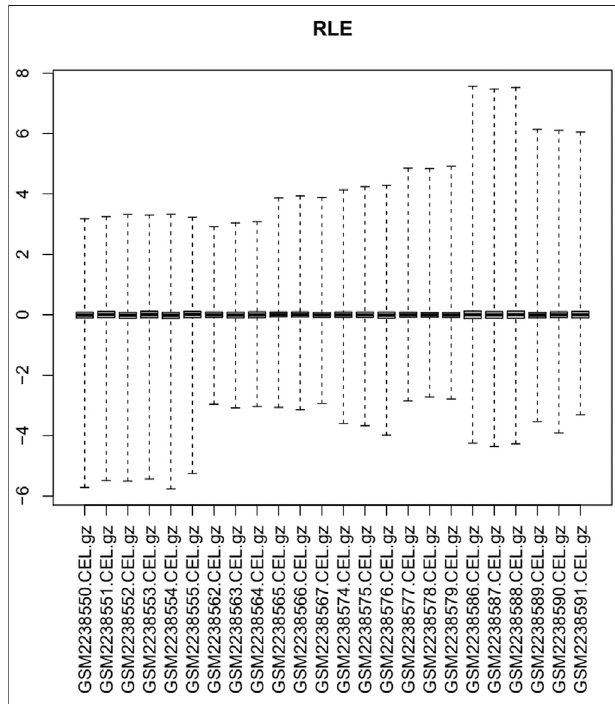
FIGURE 1 | Relative log expression diagram of the 24